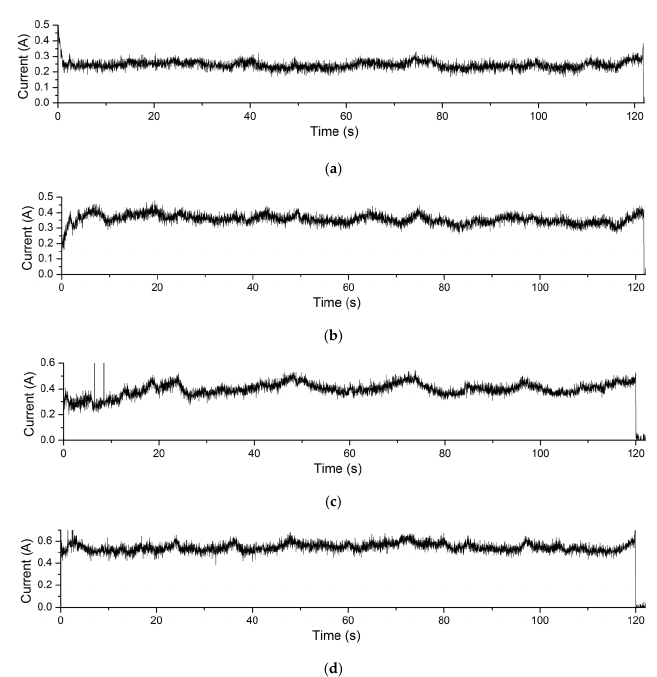
Figure 13. Processing current curves of EMAF process. ( a ) the current curve when processing voltage is 3.4 V; ( b ) the current curve when processing voltage is 3.6 V; ( c ) the current curve when processing voltage is 3.8 V; and ( d ) the current curve when processing voltage is 4.0 V.